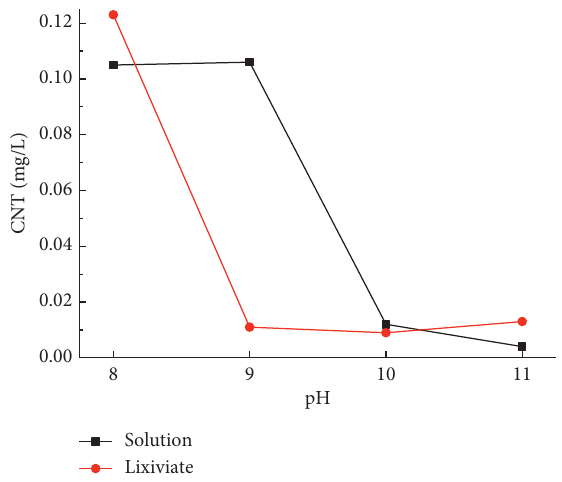
Figure 1: Cyanide as a function of pH in the presence of 0.5g/l Na